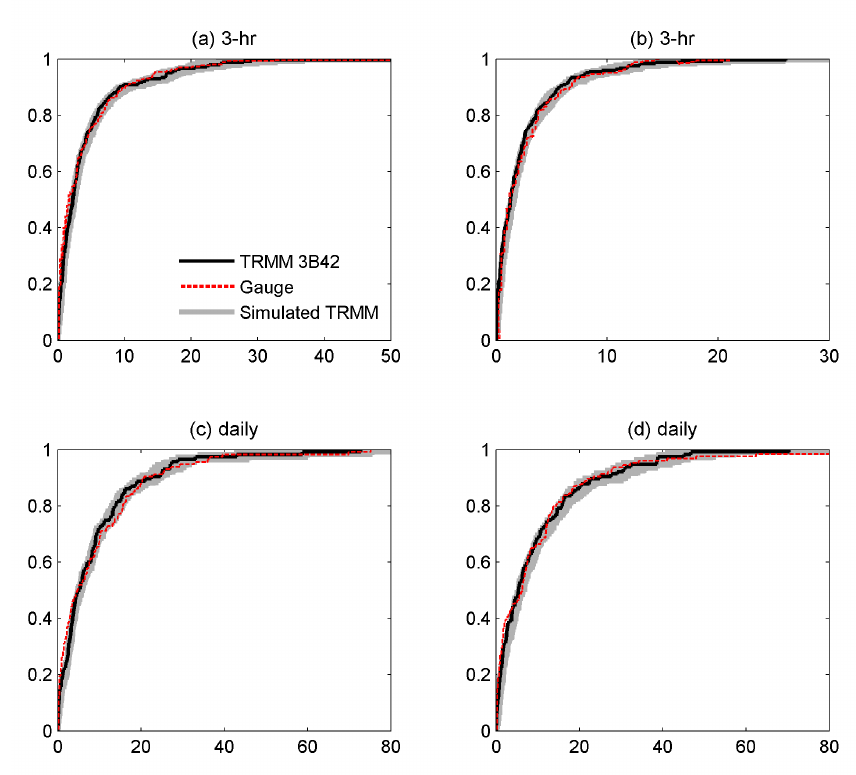
Figure 5. Empirical cumulative distribution functions for (a): 3-hour satellite estimates over the A-marked pixel; (b): 3-hour satellite estimates over the B-marked pixel; (c): daily satellite estimates over the A-marked pixel; (b) daily satellite estimates over the B-marked